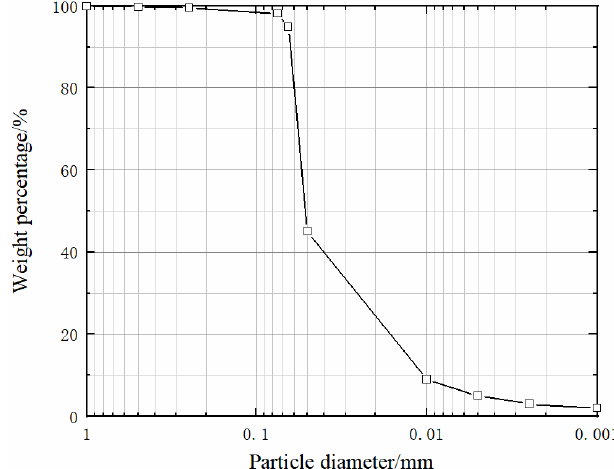
Figure 3. Particle size grading curves of sandy silt. Table 1. Test plans and parameters for